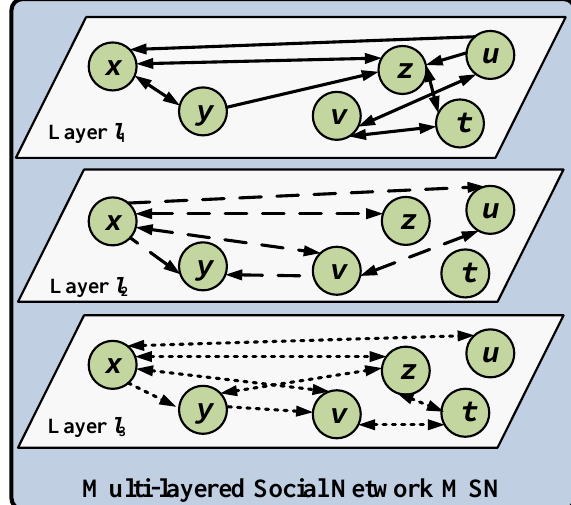
Fig. 1. An example of the multi-layered social network MSN